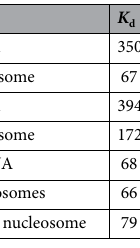
Table 1. Dissociation constants (K d ) of interactions between human cGAS and different substrates.